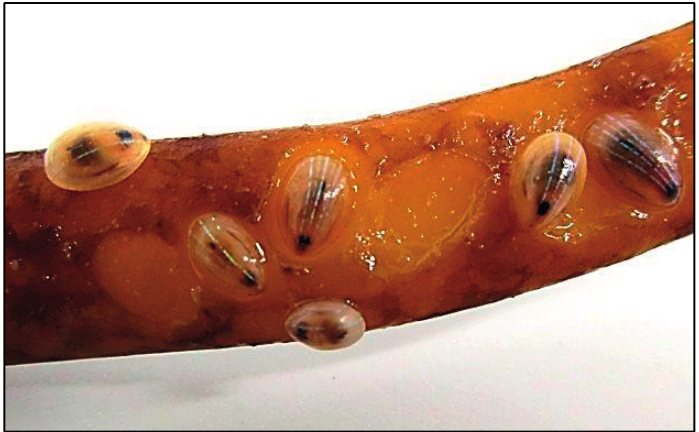
Figure 1. P. pellucida grazing on a stem of L. digitata